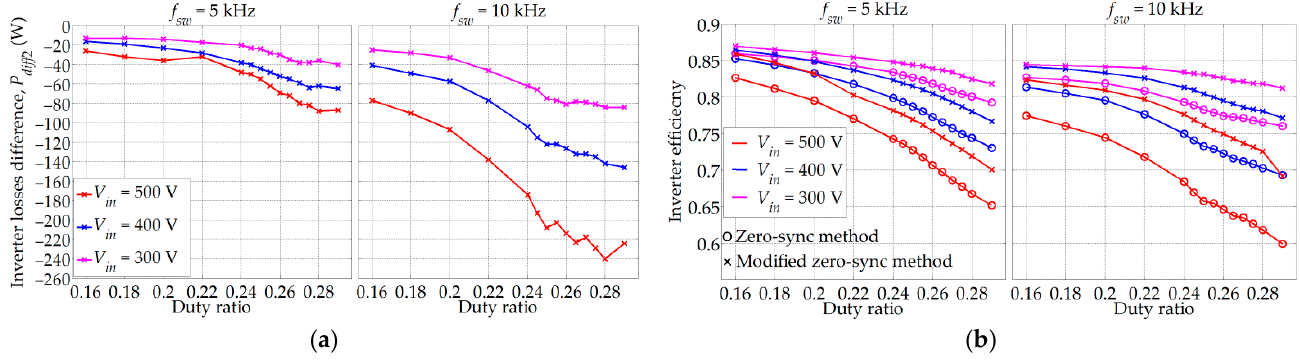
Figure 19. Inverter losses difference ( P diff 2 ) ( a ) and inverter efficiency ( b ) as a function of the duty ratio for the different values of the inverter input voltage and switching frequency.